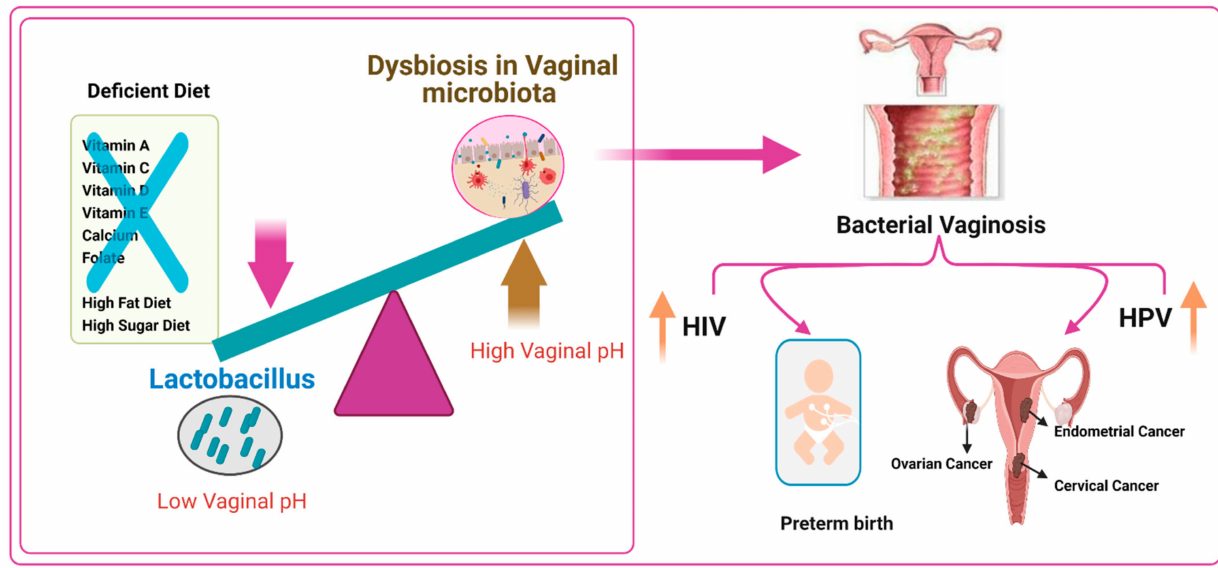
Figure 1. Impact of diet on the vaginal microbiome. A diet deficient in vitamins A, C, D, and E, calcium, folate, and beta-carotene but loaded with fats and sugar leads to altering the vaginal microbiota and increase susceptibility to infections causing bacterial vaginosis, which are associated with preterm birth, raising the risk of human immunodeficiency virus (HIV) transmission, human papillomavirus (HPV) infection, and cervical, endometrial, and ovarian